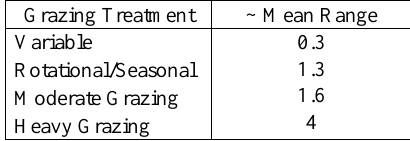
Table 2. Approximate mean range for each treatment type